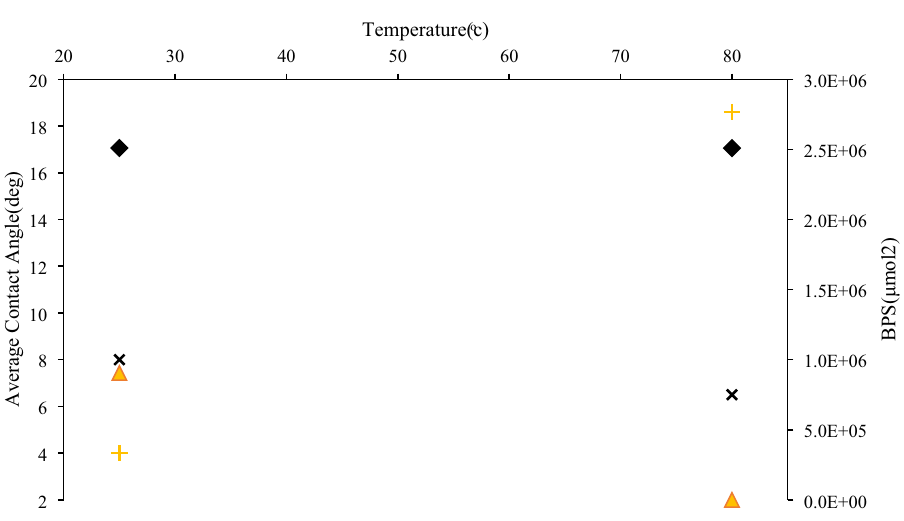
Figure 5. Calculated BPS of limestone A and dolomite (BPS-LS A and BPS-dolomite) and average contact angle change of the rocks (AvgCA-LS A and AvgCA-dolomite) reported by Mahani et al. 19 .